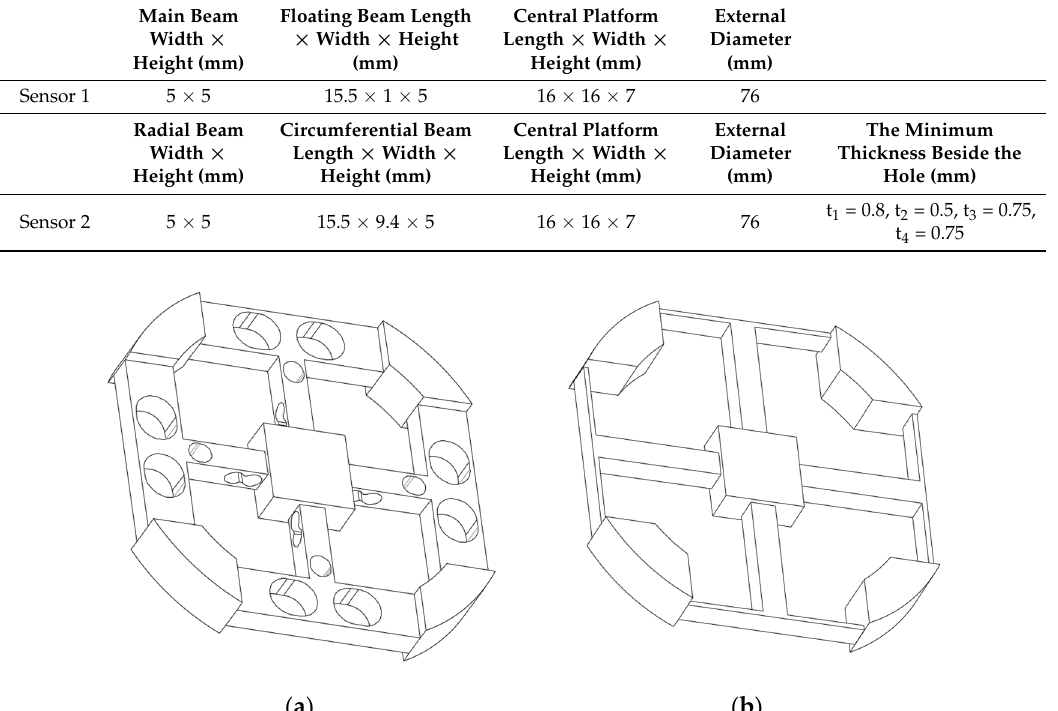
Table 4. Dimensions of two sensor models